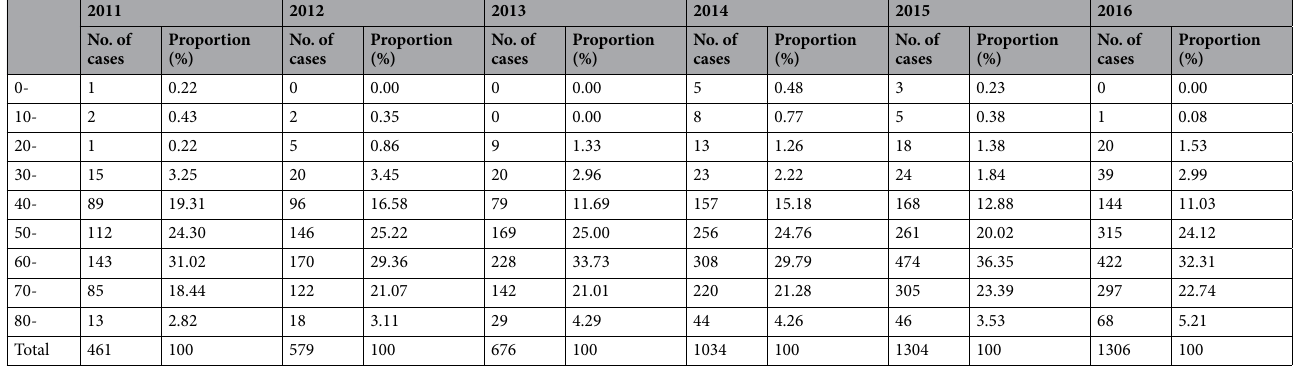
Table 1. Age distribution of SFTS cases in China from 2011 to 2016.